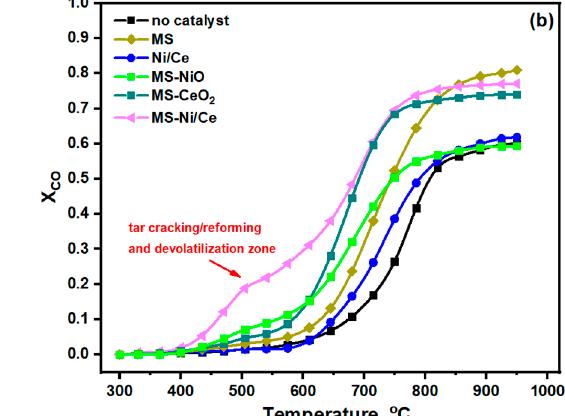
Figure 6. Effect of temperature and catalyst addition on the conversion of carbon to CO during non- isothermal CO 2 gasification experiments. Gasifying agent flowrate = 30 cm 3 /min of 20 vol.% CO 2 in Helium.